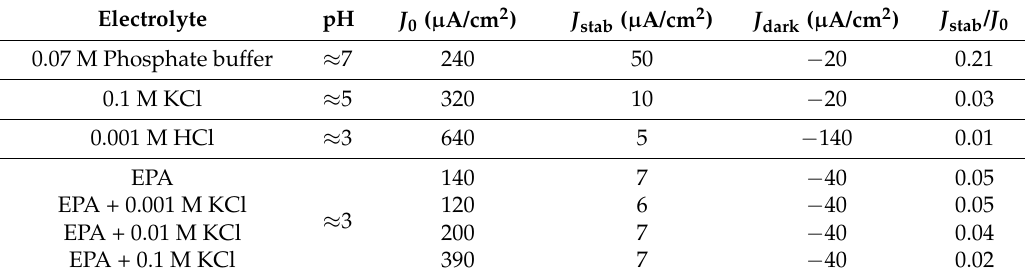
Table 1. Parameters of the time traces of the photocurrent for the photoanode sensitized with both RuOEC and RuP.